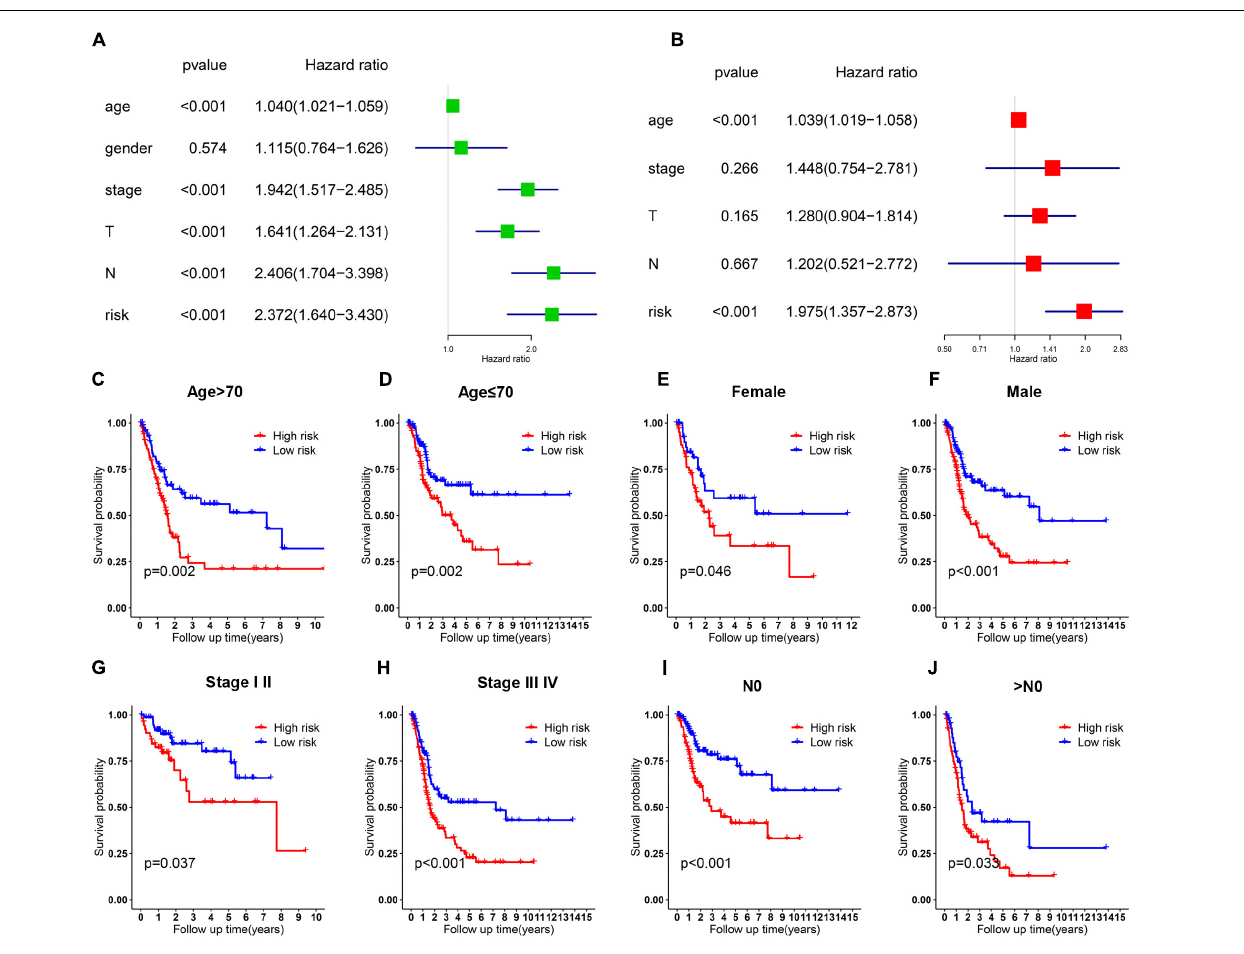
FIGURE 4 | Cox regression and stratified analysis of the 6 gene risk model. (A,B) Results of univariate and multivariate regression analysis of the relation between clinical features and risk model. (C–J) Kaplan–Meier survival curves for bladder cancer patients with age (C,D) , gender (E,F) , stage (G,H) , and N metastasis (I,J)